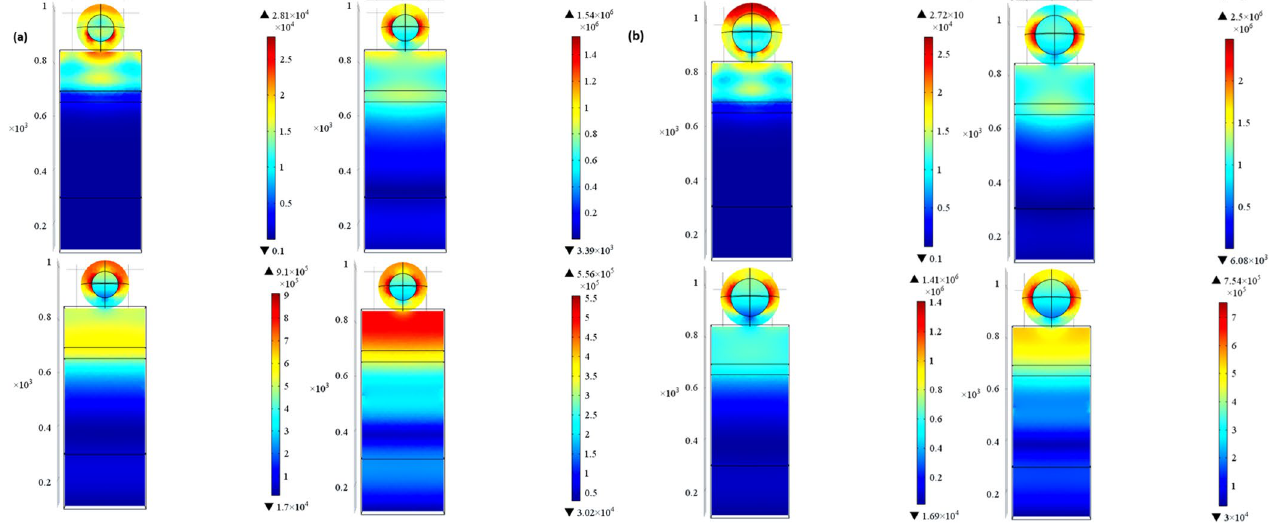
Figure 9. Electric field profiles of ZrN/SiO 2 core-shell-decorated PSCs: ( a ) 90 nm (50 nm core surrounded by 40 nm shell) and ( b ) 115 nm (75 nm core surrounded by 40 nm shell) at wavelengths of 300 nm, 800 nm, 1000 nm and 1200 nm, respectively.